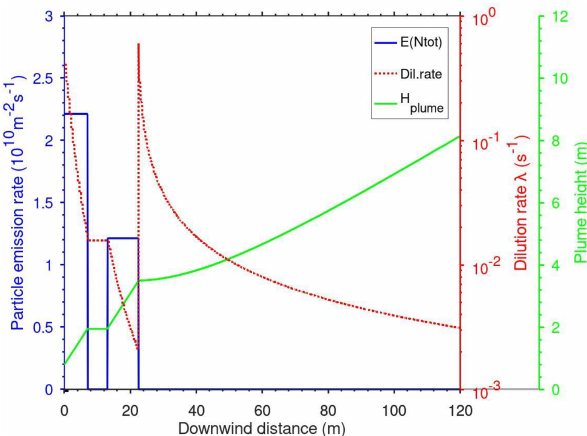
Figure E1. Plot of emission rate of exhaust particles in 10 10 m − 2 s − 1 (blue line), dilution rate, λ dil , (red dotted line), and air parcel height (green line) as a function of time after simulation start in the Urban Case scenario. The plume height and the dilution rate are constant while the air parcel passes over the tram tracks in the middle of the